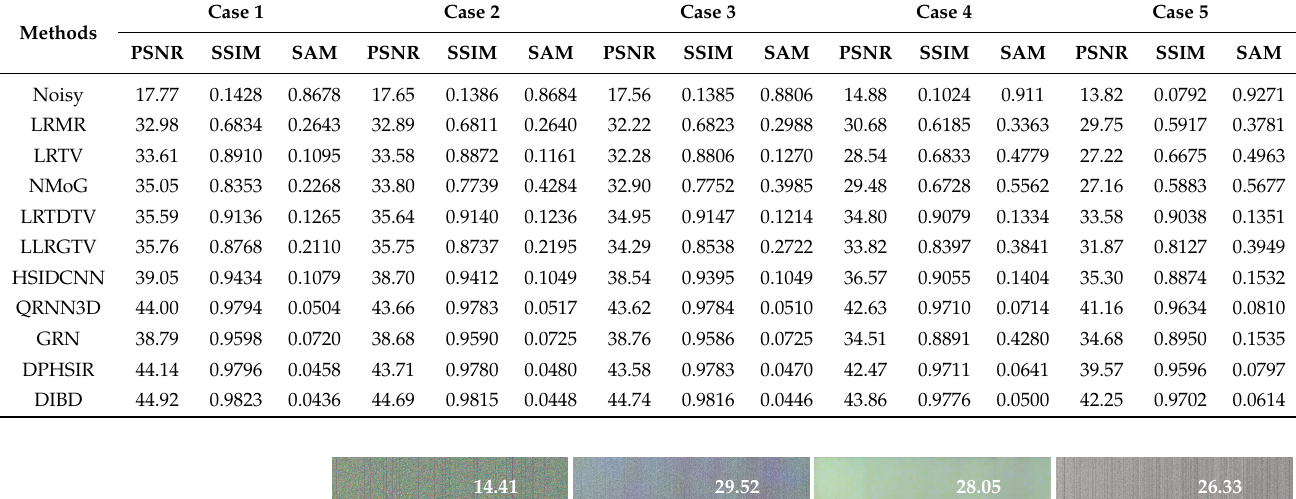
Table 6. Quantitative evaluation of all the competing methods under different complex noise cases on the ICVL dataset. All denoising methods work in the blind way.